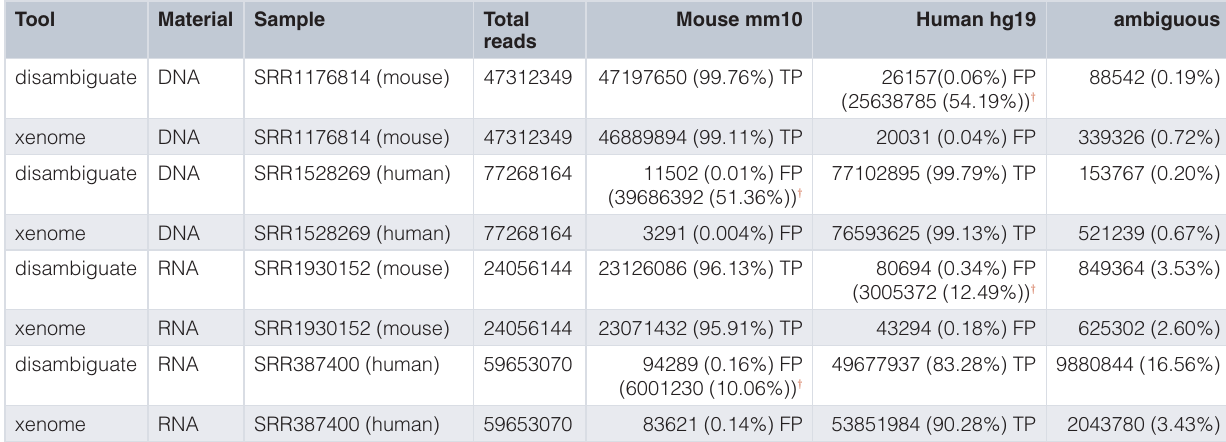
Table 1. Read pairs assigned human (hg19) and mouse (mm10) by both the disambiguate and xenome algorithms. The ’ambiguous’ column includes reads that aligned but could not be unambiguously disambiguated. The † symbol and the numbers